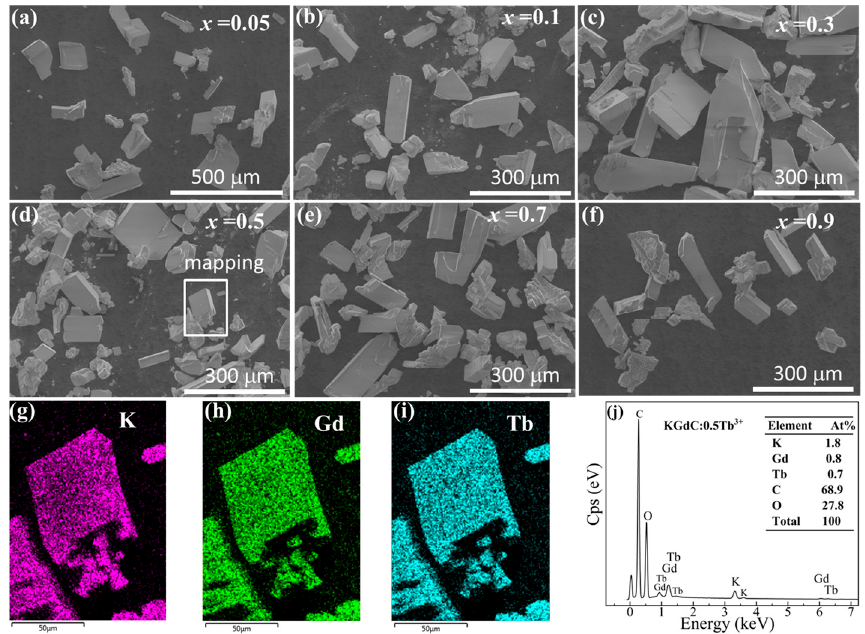
Figure 2. ( a – f ) Morphologies of KGdC: x Tb 3+ ( x = 0.05, 0.1, 0.3, 0.5, 0.7, 0.9); ( g – i ) Elemental mapping of K, Gd, and Tb; ( j ) Energy dispersive spectroscopy analysis.